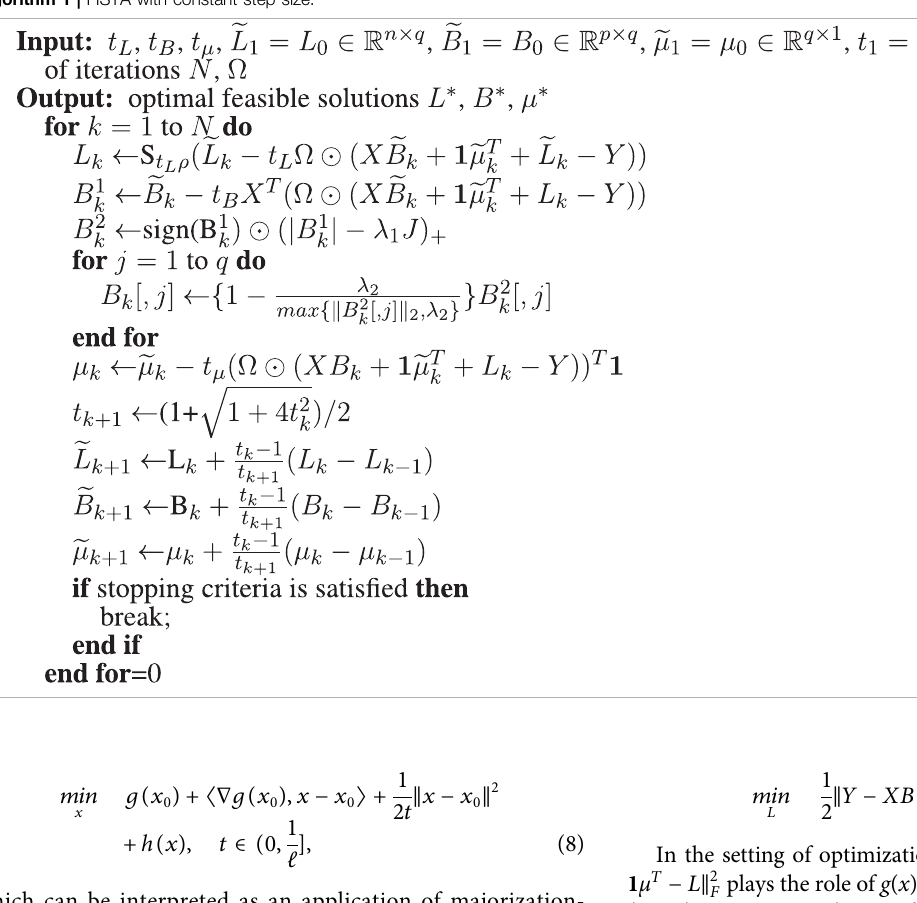
Algorithm 1 | FISTA with constant step